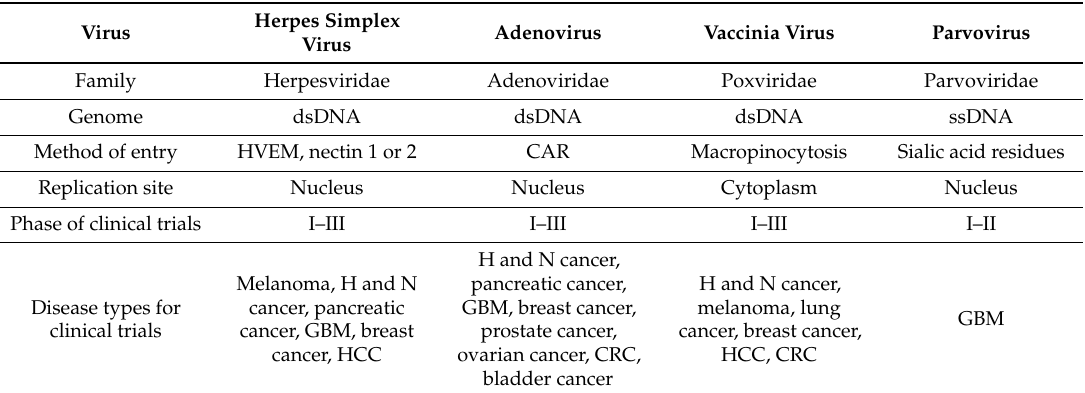
Table 1. Features of selected DNA oncolytic